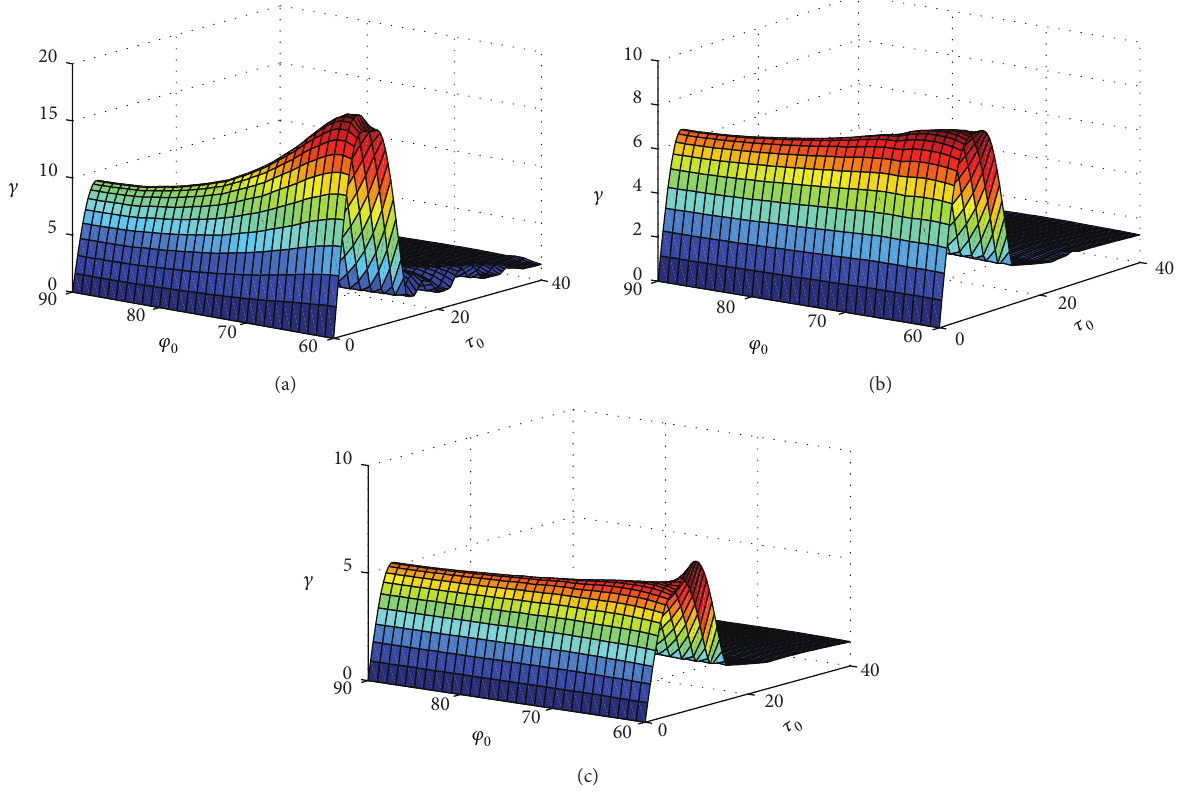
Figure 9: The effect of the mass ratio on three-dimensional shock response spectrum of critical components: (a) 𝜆 2 = 0.01 ; (b) 𝜆 2 = 0.05 ; (c) 𝜆 2 = 0.1